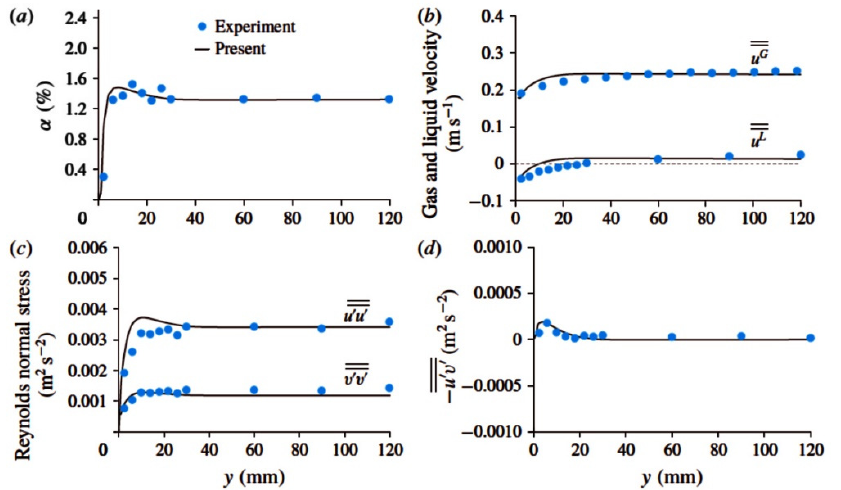
Figure 7. Comparison between the model of Ma et al. [231] and the experimental data of Akbar et al. [233]: ( a ) gas void fraction, ( b ) streamwise velocities of the liquid and gas phases, ( c ) Reynolds normal stresses of the liquid phase, ( d ) Reynolds shear stress of the liquid